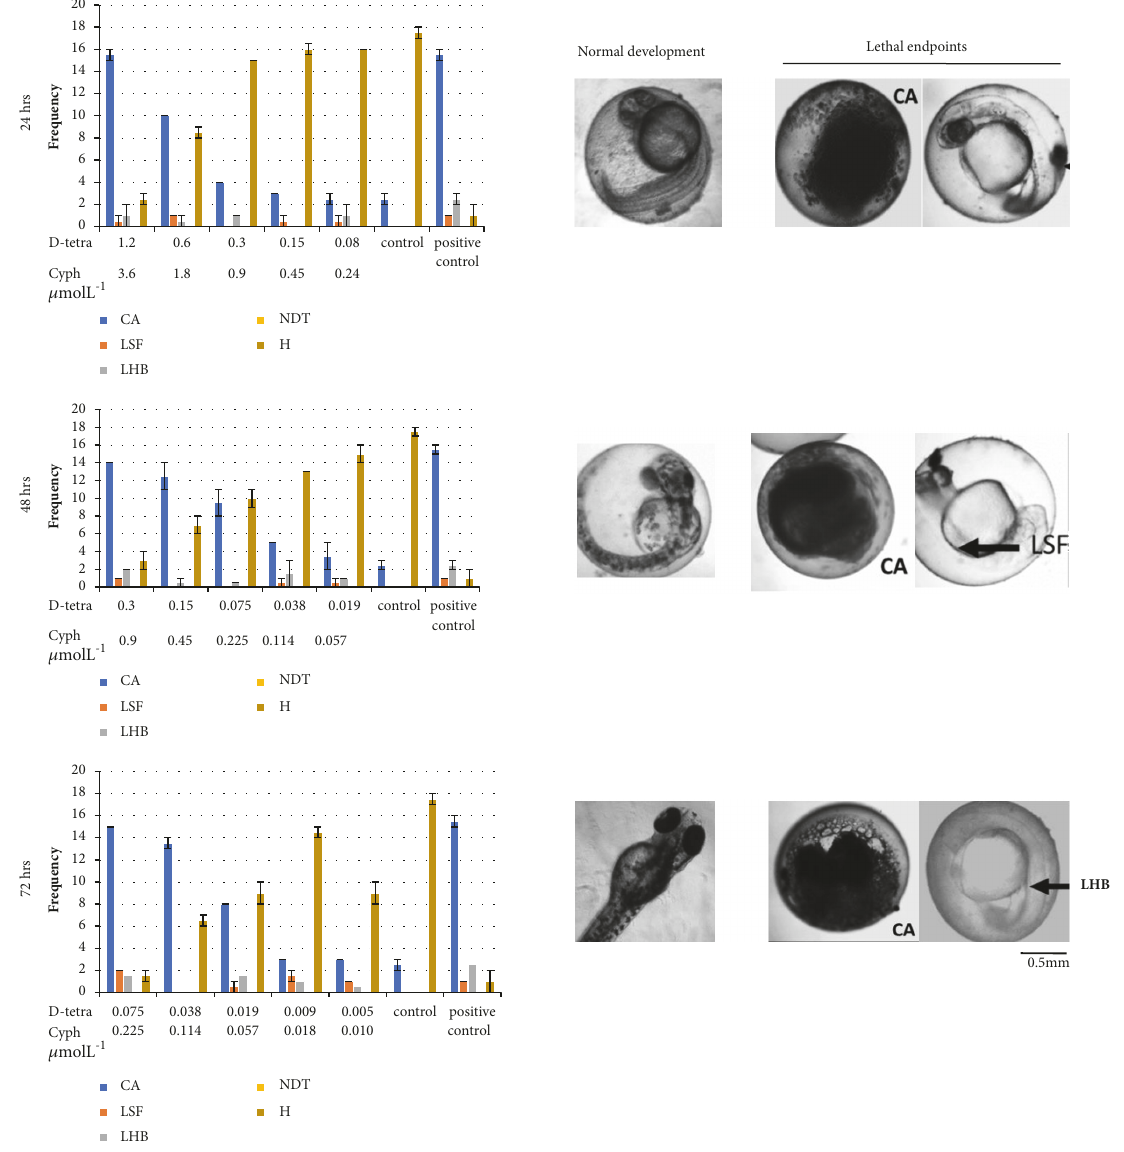
Figure 2: Types and frequencies of lethal effects observed in zebrafish embryos when exposed to binary mixture of d-tetramethrin and cyphenothrin at different time intervals: 24, 48, and 72 hrs. CA: coagulation, LSF: lack of somite formation, LHB: lack of heartbeat, NDT: None-detachmentof tail, H: numberof hatchedembryos D-tetra:tetramethrin,Cyph: Cyphenothrin. Control: dilution water,positive control (4 mgL-1 (24.69 𝜇 molL-1)